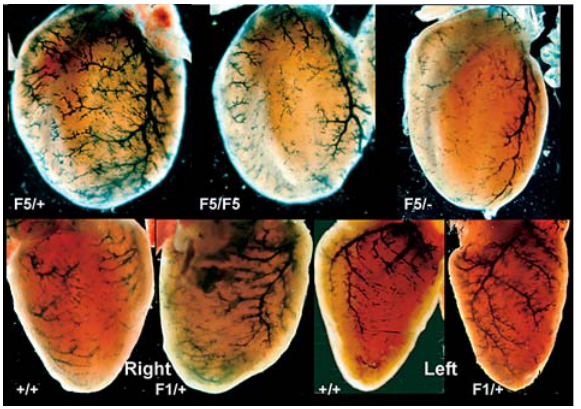
Figure 9. Vascular Smooth Muscle Cells of the Coronary Arteries (Top) Whole-mount views of P21 hearts from littermates of the F5 alleles of mutant mice. Hearts were sliced coronally, and the ventral surface was photographed. The F5/ (cid:1) heart was sliced disproportion- ately and therefore appears to be smaller. (Bottom) P28 hearts from wild-type and F1 littermates. Hearts were sliced sagittally. Both the left and right views are shown. DOI: 10.1371/journal.pbio.0000052.g009